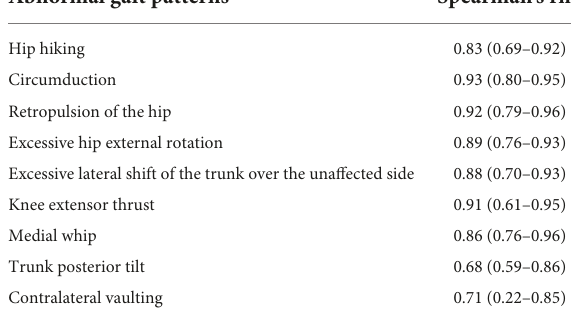
TABLE 2 Index values of abnormal gait patterns calculated by the marker-based motion capture system using three-dimensional (3D) gait analysis system.